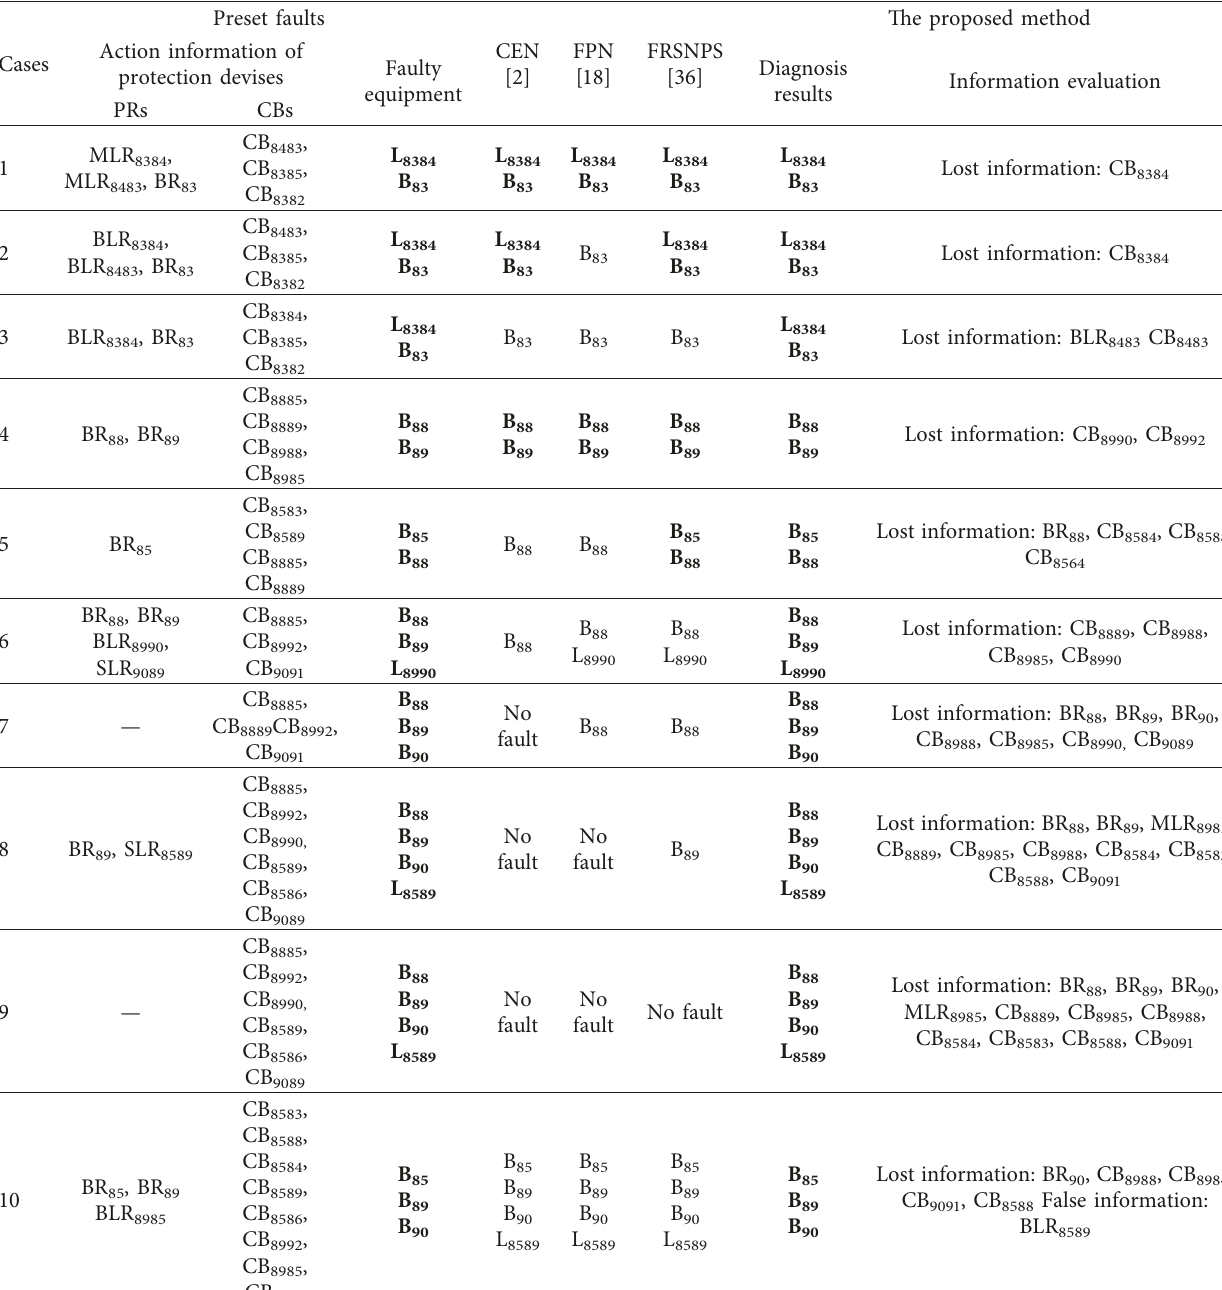
Table 6: Comparisons of diagnosis results between the proposed method and three typical fault diagnosis methods for the 118-bus system.